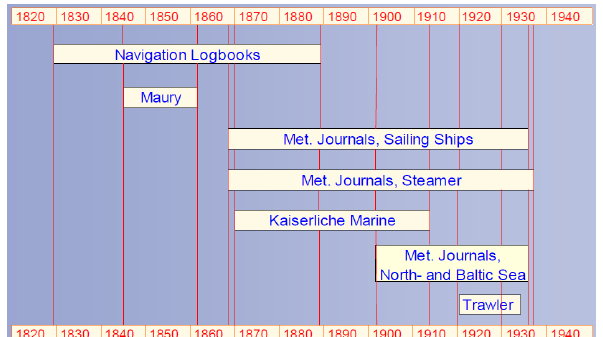
Figure 5. Data sources of ship-based weather observations of Ger- man Naval Observatory Hamburg.